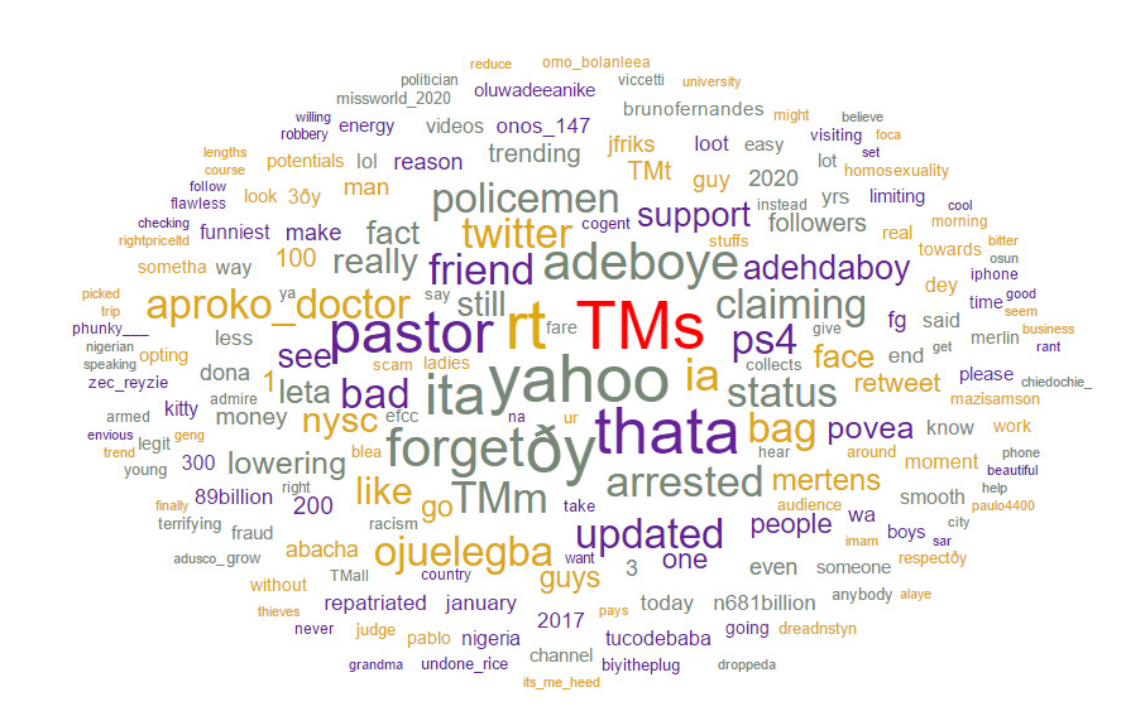
Figure 4. Word Cloud showing the tokens and their frequency/weight from the pre-processed tweet dataset. Table 2. The topmost frequent tokens with their frequency/weight.